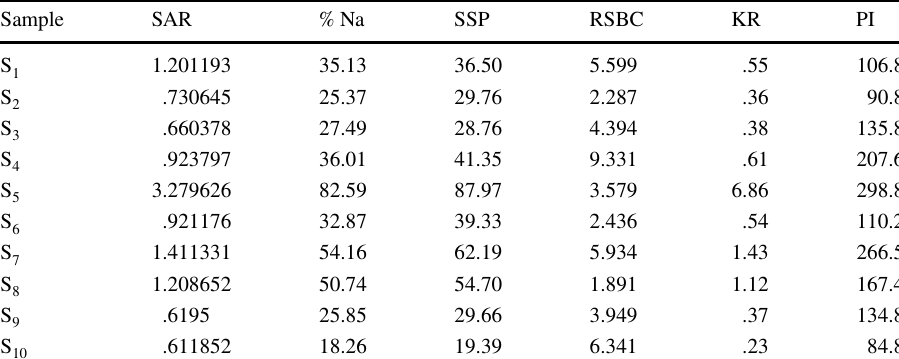
Table 9 Irrigation parameters during wet season